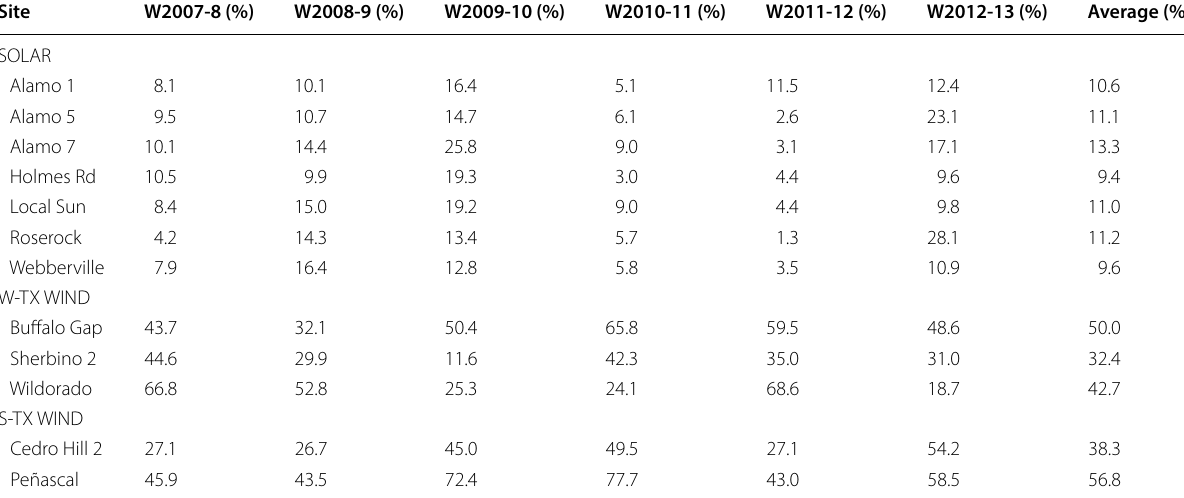
Table 2 Peak average capacity percentages for each solar and wind site during each winter